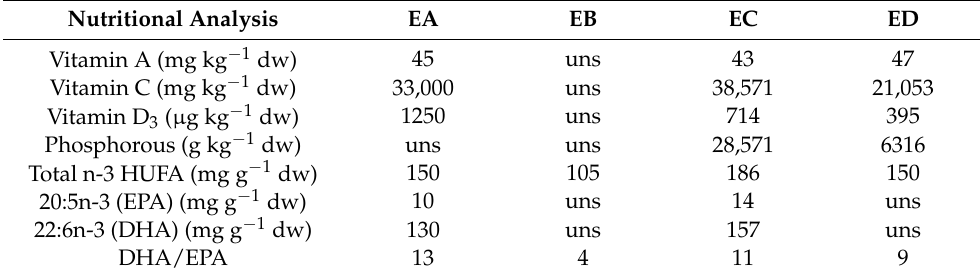
Table 3. Nutritional information for each enrichment (EA, EB, EC, ED) according to the manufacture’s label. DHA: docosahexaenoic acid; dw: dry weight; EPA: eicosapentaenoic acid; HUFA: highly unsaturated fatty acids; uns: unspecified. Nutritional